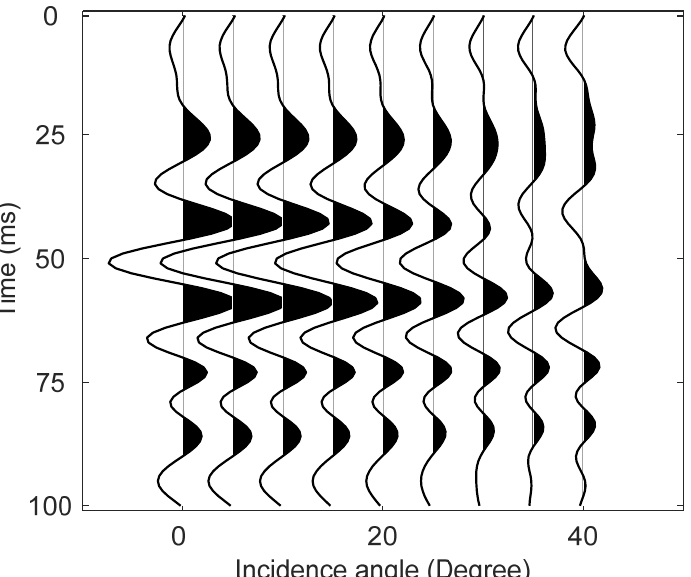
Figure 3. The input synthetic seismic gather for model test generated by using the well logs of Figure 2.